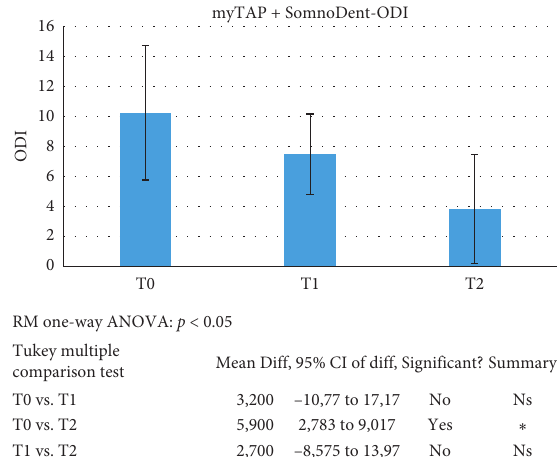
Figure 10: ANOVA and post hoc Tukey test were applied to evaluate the efficacy of the proposed therapeutic pathway: trial (T1) followed by definitive device (T2). Significance for all statistical tests was set at p < 0 . 05